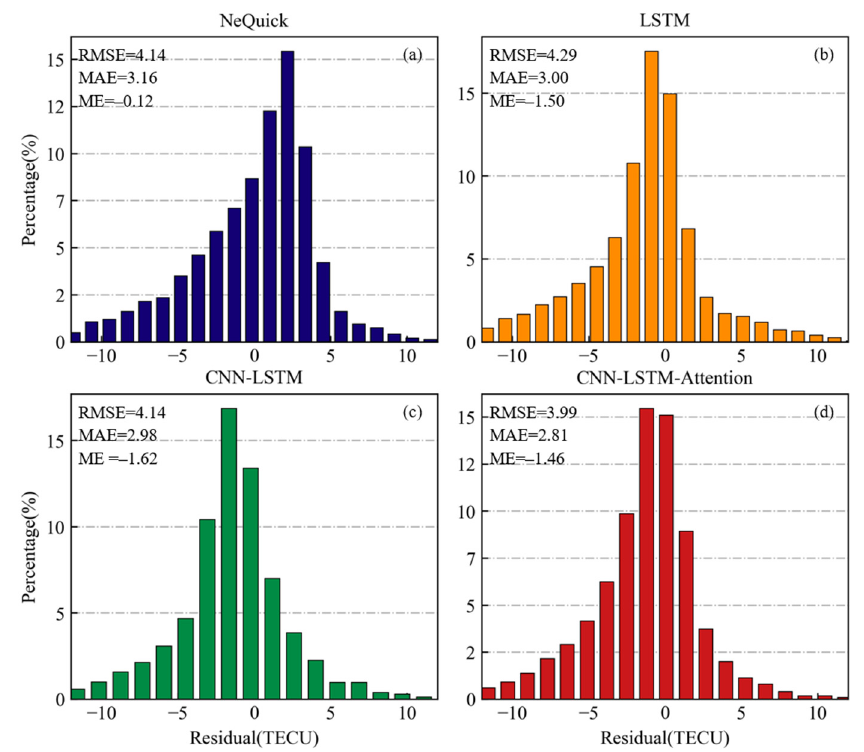
Figure 12. Residual distribution of different models for GDZH station during magnetic quiet period. RMSE, MAE, and ME are also included. ( a ) NeQuick; ( b ) LSTM; ( c ) CNN-LSTM; ( d ) CNN-LSTM- Attention model.